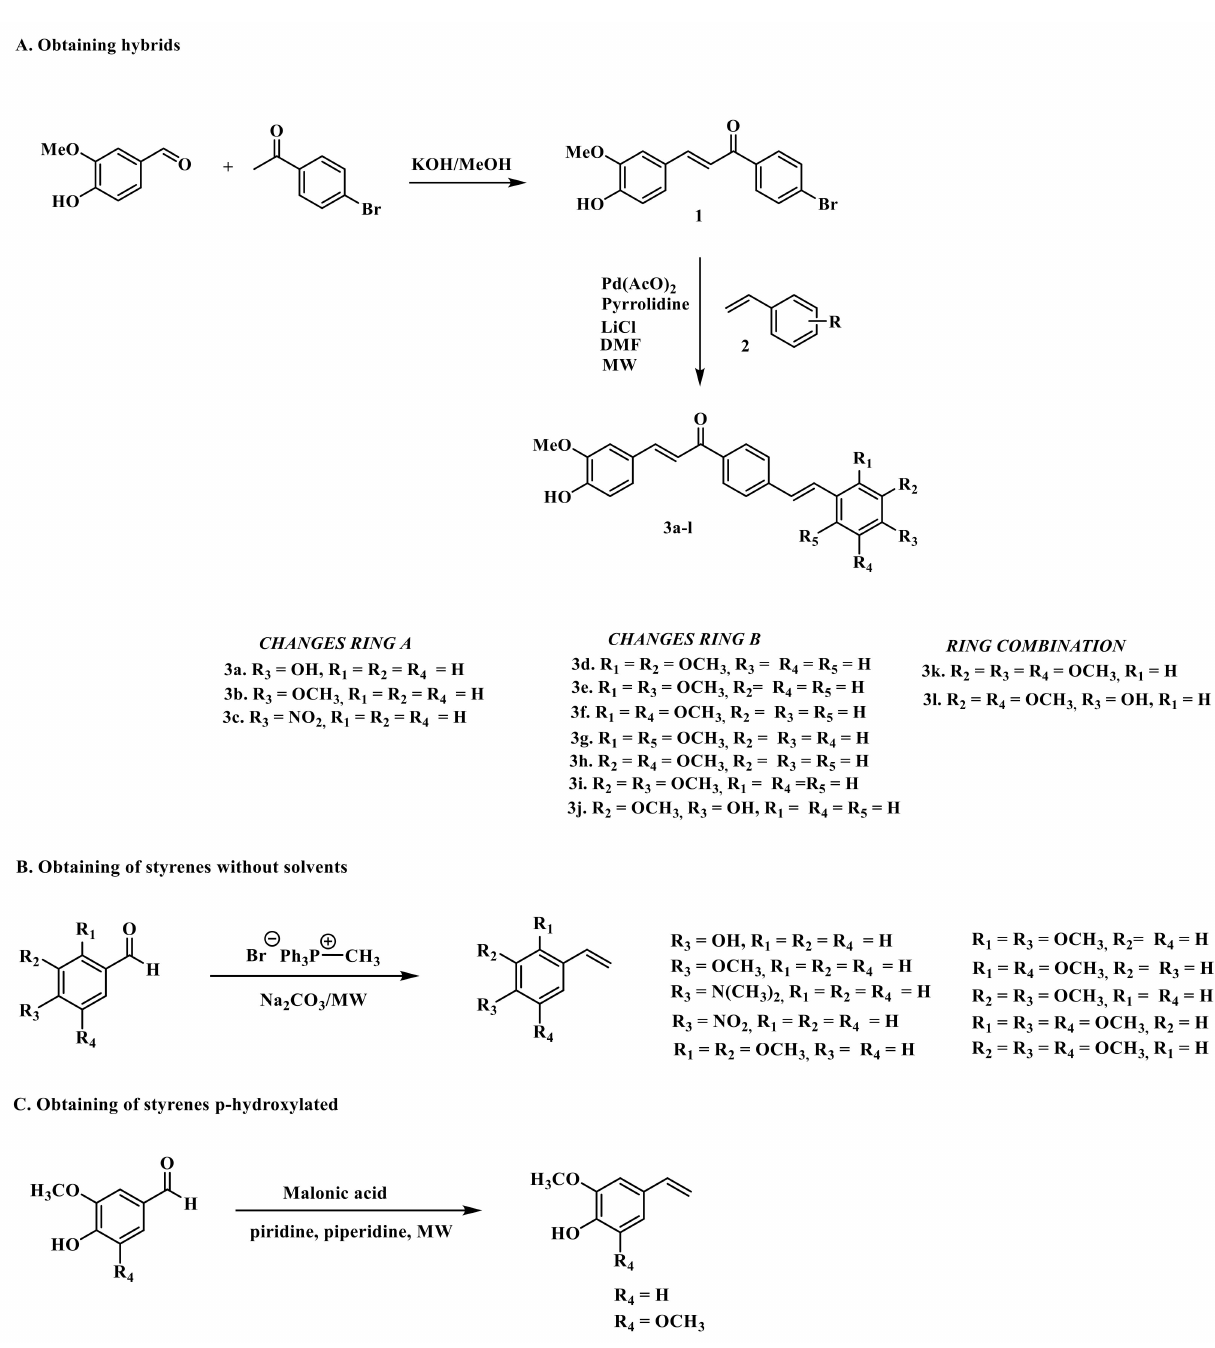
Scheme 1. Synthesis of hybrids based on curcumin and